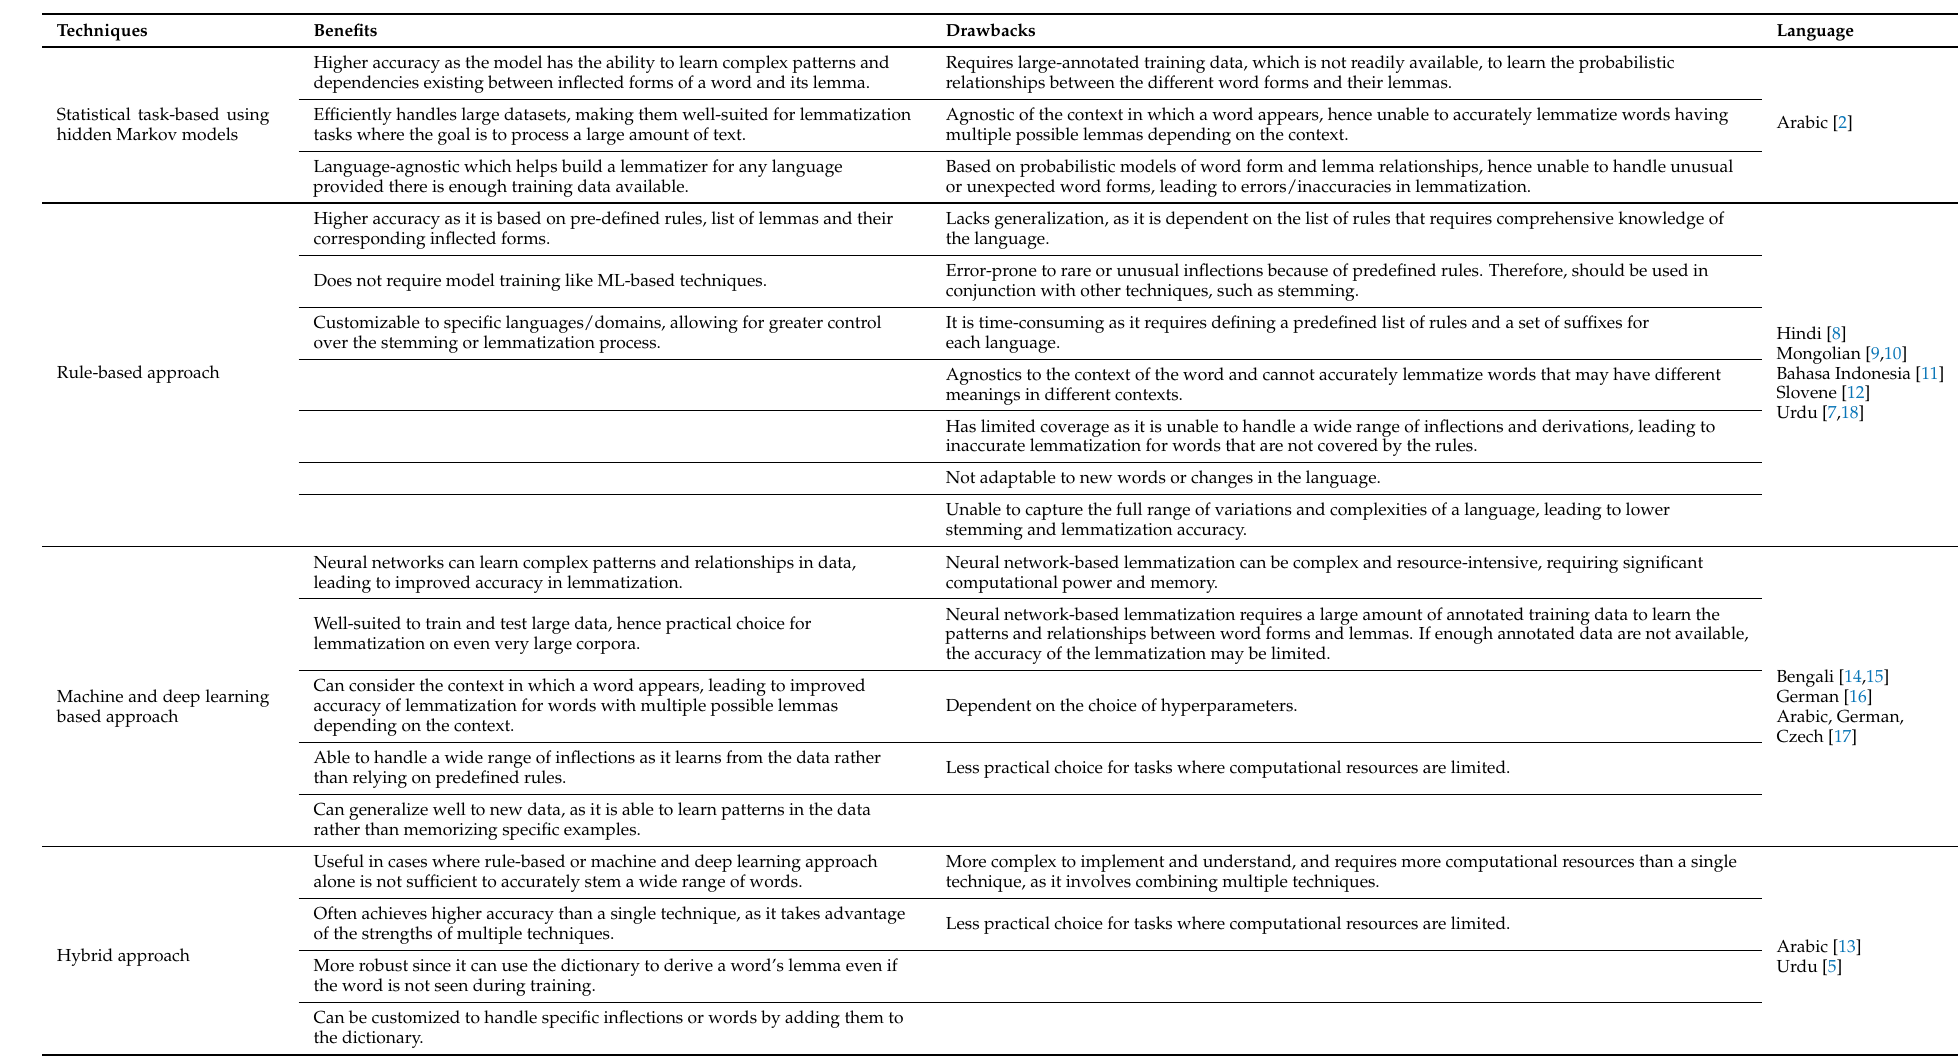
Table 1. Summary of different lemmatization approaches applied for various resource-scarce